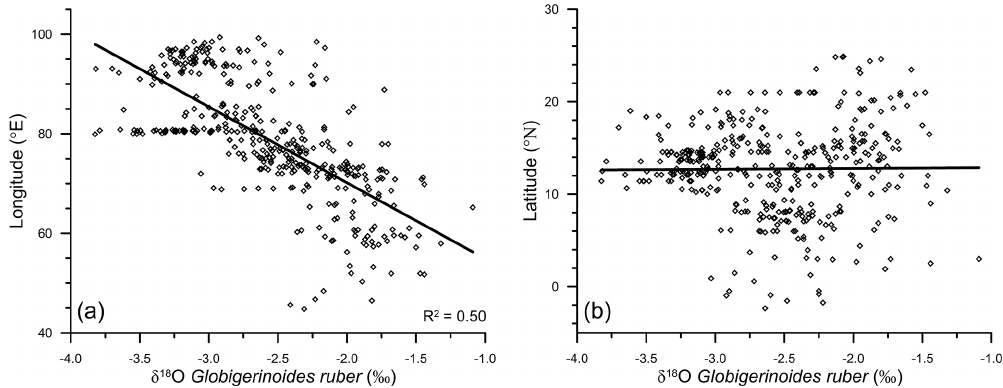
Figure 4. The variation in Globigerinoides ruber δ 18 O (‰), with the corresponding longitude (a) and latitude (b) , in the surface sediments of the northern Indian Ocean. The correlation between δ 18 O ruber and the latitude of the sample is